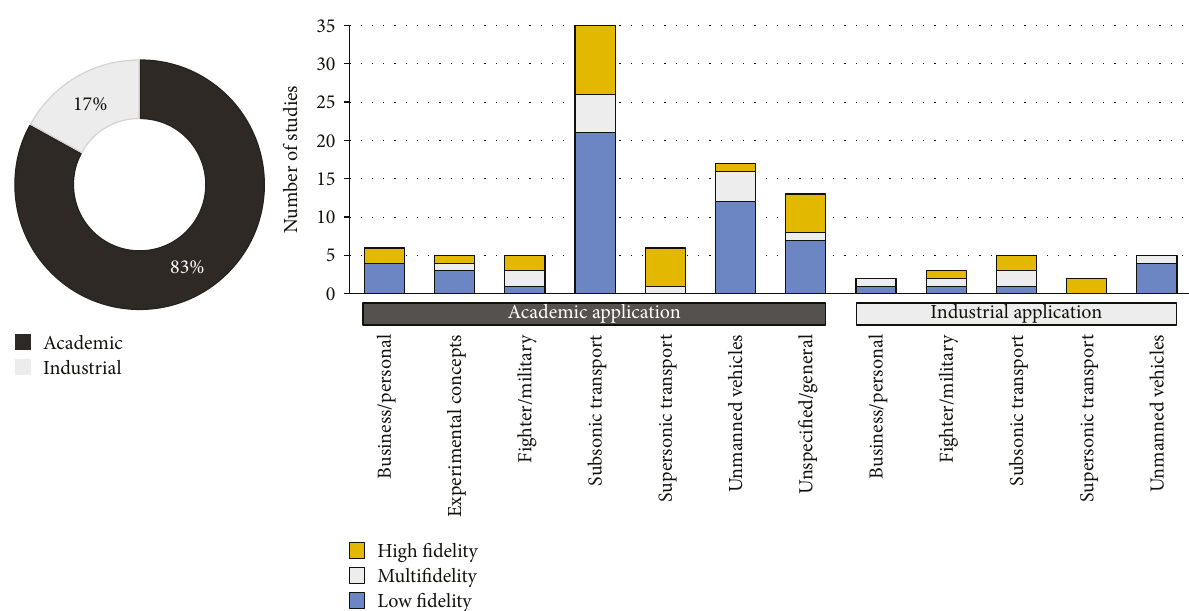
Figure 8: The di ff erent types of MDO applications and the corresponding intended level of